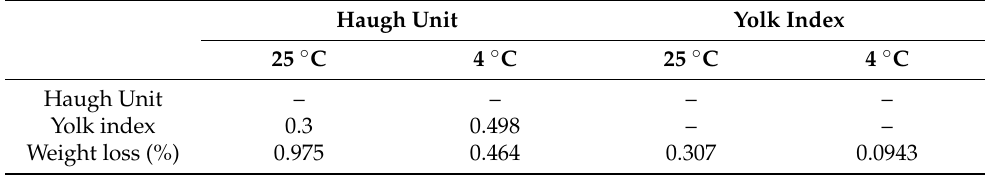
Table 2. Relationship of physical indexes (R 2 ) of eggs stored at temperature of 4 ◦ C and 25 ◦ C. Haugh Unit Yolk Index 25 ◦ C 4 ◦ C 25 ◦ C 4 ◦ C Haugh Unit – – – – Yolk index 0.3 0.498 – – Weight loss (%) 0.975 0.464 0.307